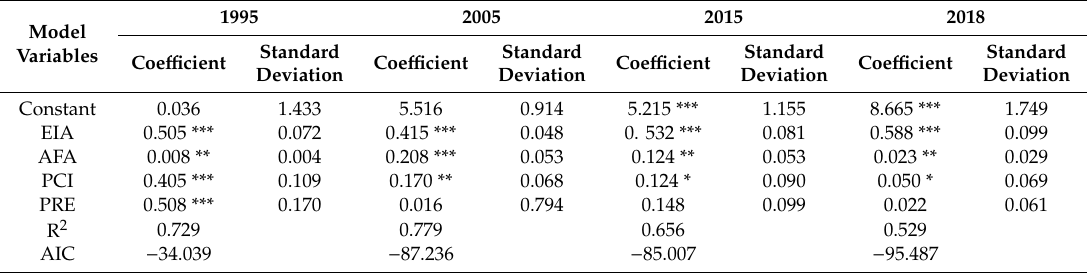
Table 4. Regression analysis results of the spatial lag